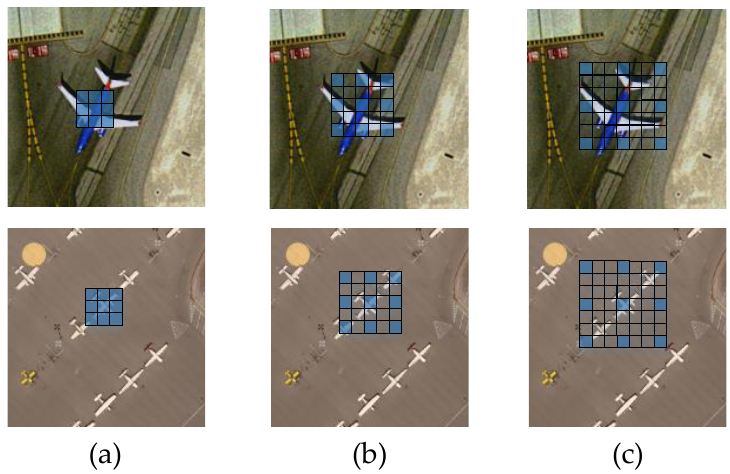
Figure 3. Effects of different receptive fields on different samples. ( a ) Receptive field of 3 × 3 convolu- tional kernel with dilation rate = 1. ( b ) Receptive field of 3 × 3 convolutional kernel with dilation rate = 2. ( c ) Receptive field of 3 × 3 convolutional kernel with dilation rate = 3.